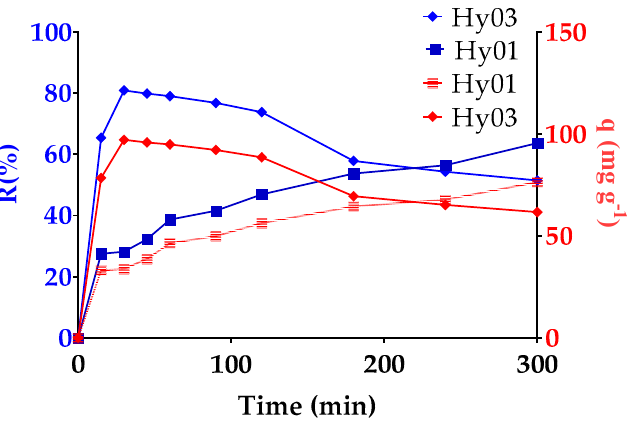
Figure 7. Dye retention and capacity of adsorption per gram of resin by hydrogel as a function of time for Hy01 and Hy03 at pH 7.64.